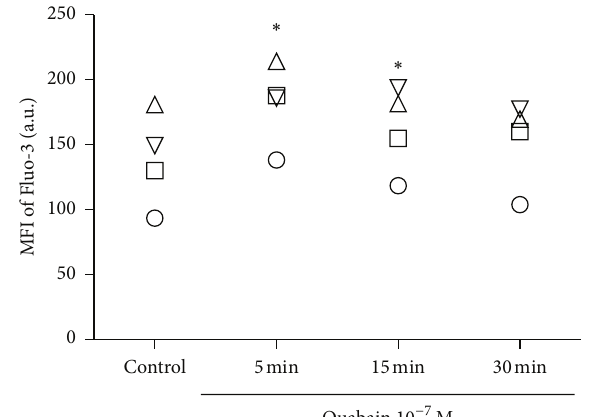
Figure 5: Allogeneic Mixed Leukocyte Reaction (MLR) ability of ouabain-treated monocytes. Ouabain-treated and control mono- cytes were cocultured with lymphocytes from a second donor using the ratio of 1:1 (monocyte:lymphocyte) for 5 days followed by an 18 h pulse with [ 3 H]thymidine to assess the proliferative response. Results are expressed as mean c.p.m. ± SEM of four independent experiments. Each condition in these experiments was performed in